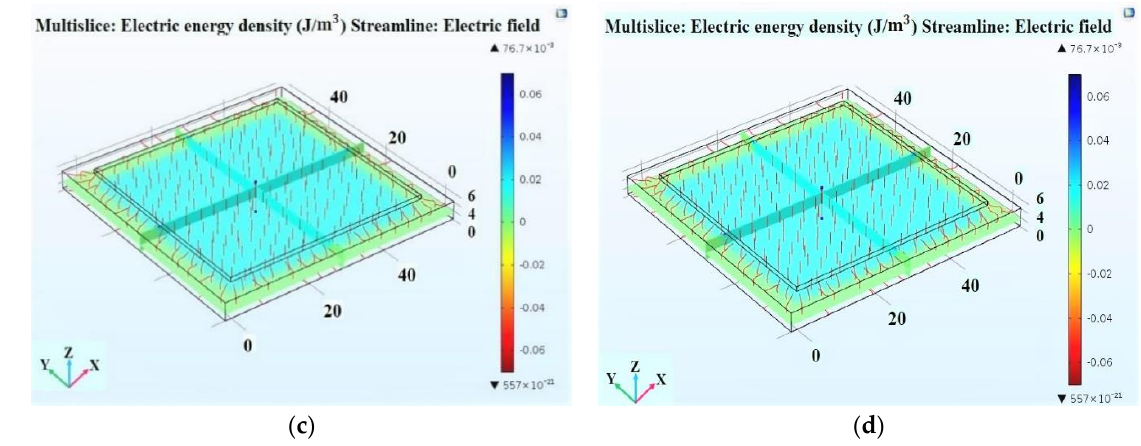
Figure 20. ( a ) Single module capacitor incorporates with dry sand in ANYSYS Maxwell Simulation. ( b ) Material electric energy density (for dry sand) with coating thickness of 0 mm. ( c ) Material electric energy density (for dry sand) with coating thickness of 0.5 mm. ( d ) Material electric energy density (for dry sand) with coating thickness of 1 mm.